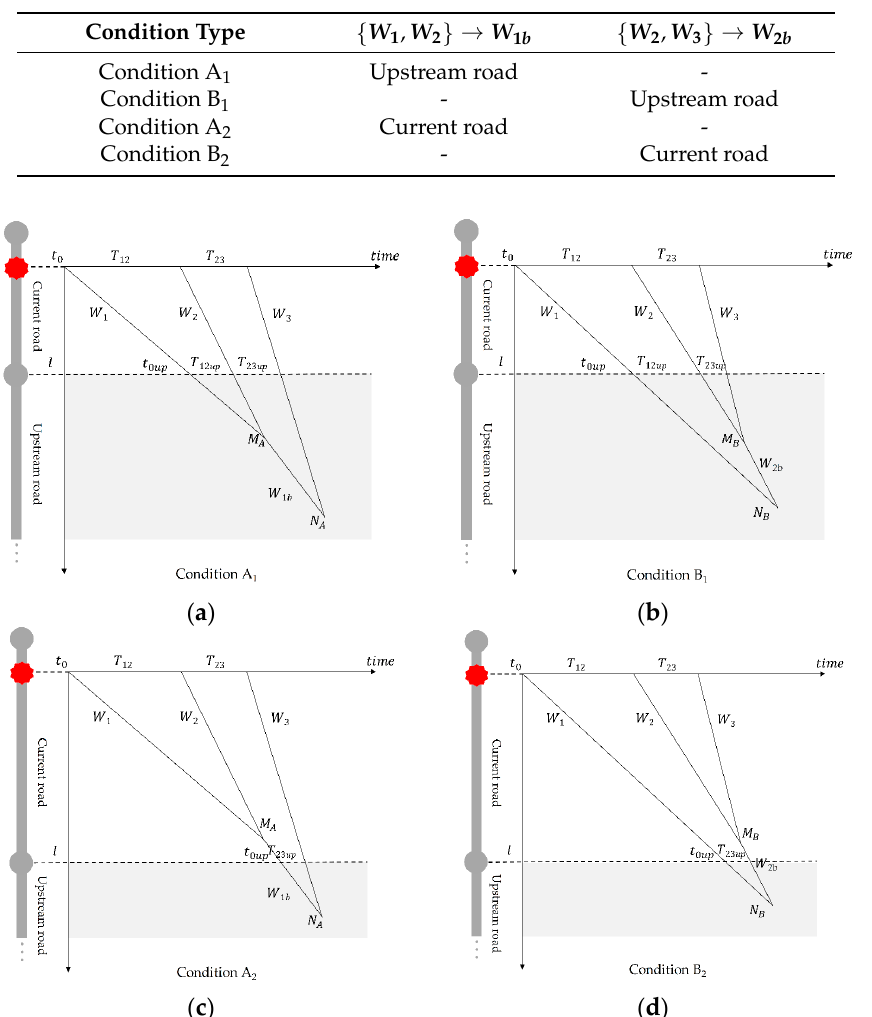
Figure 4. Propagation conditions: ( a ) Condition A 1 ; ( b ) Condition B 1 ; ( c ) Condition A 2 ; and ( d ) Condition B 2 . The illustrations of road sections on the left are similar to that in Figure 2. The current road section is on the white background, and the upstream road section is on the gray background. The dashed line ‘ (cid:1864) ’ represents the length of the current road